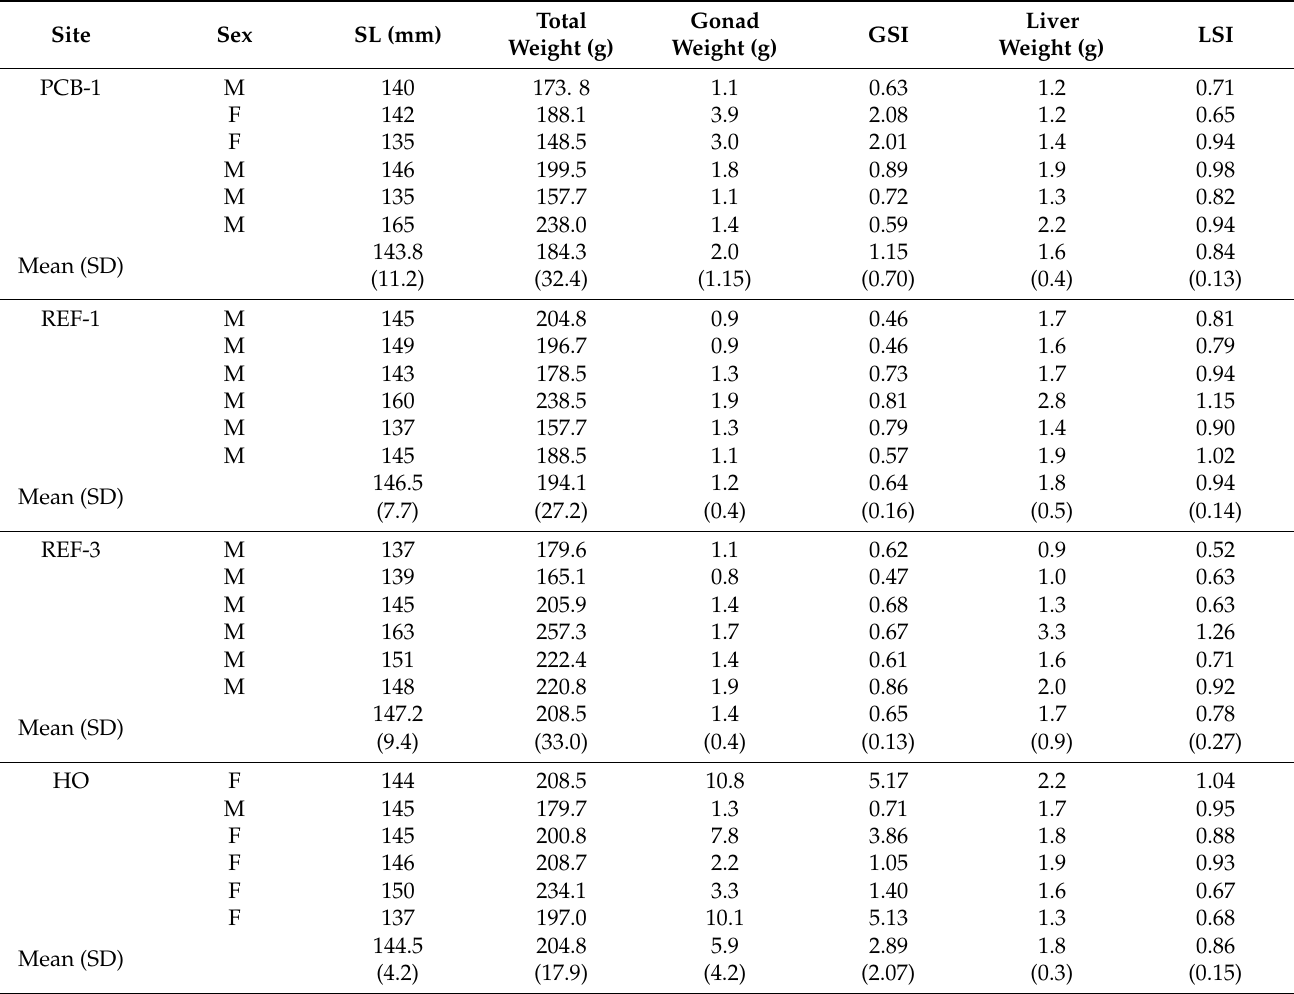
Table 3. Individual fish data used to calculate the gonadosomatic and hepatosomatic indices from four sites within Johnston